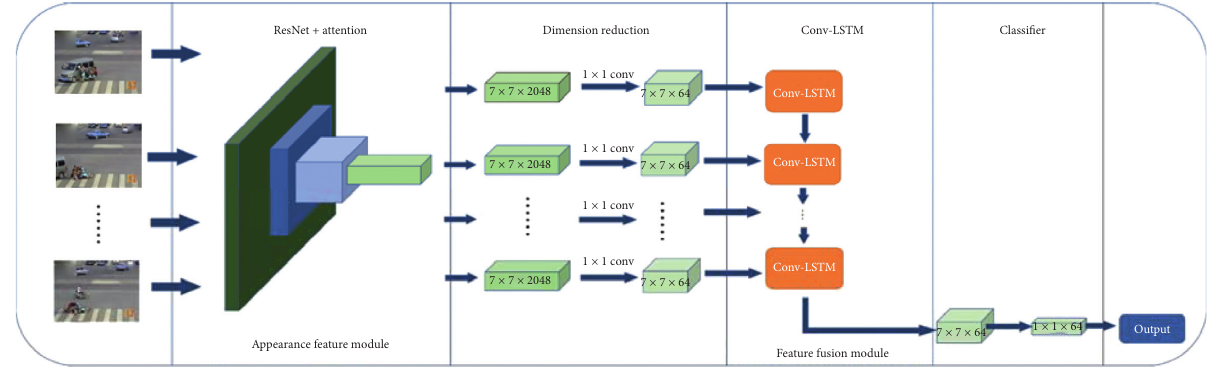
Figure 1: The proposed crash detection model